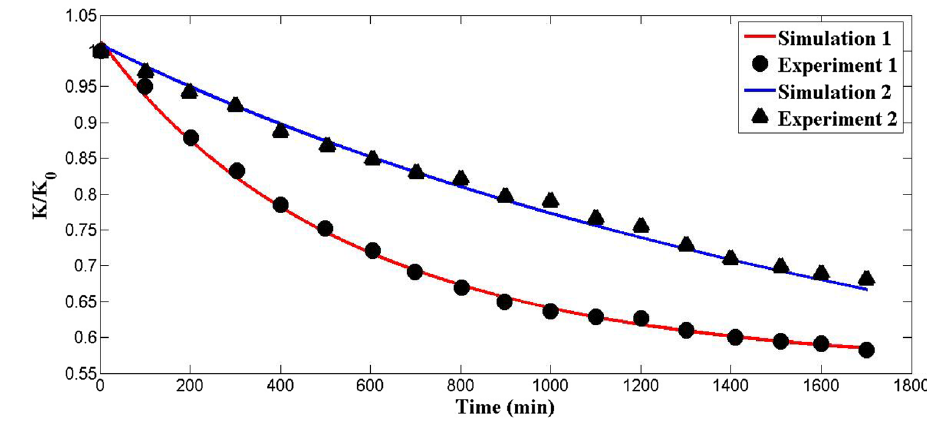
Fig. 2 Results of the simula- tion in the core scale for the experiments of Moghadasi et